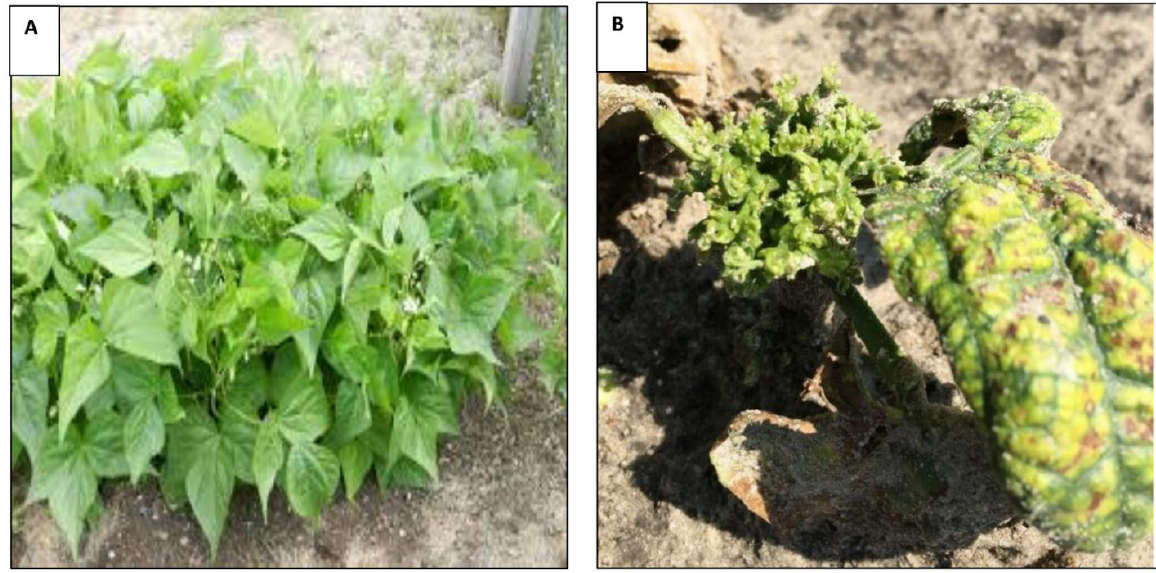
Figure 1. Symptoms of leaf crumple on P. vulgaris plants under field conditions. A non-infected P. vulgaris ( A ) and an infected plant ( B ) with severe stunting, leaf crumpling and distortion, and leaf mosaic symptoms.